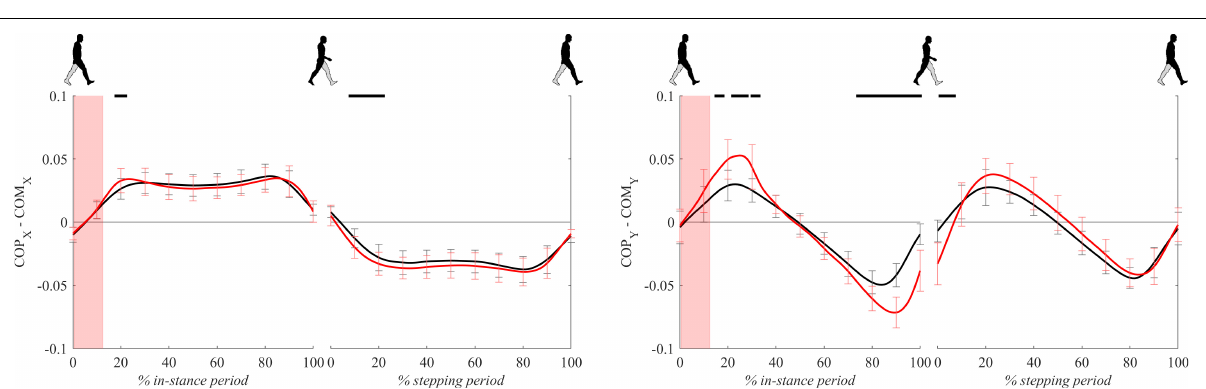
FIGURE 7 | Dimensionless group-average COP-COM responses after outward perturbations ( N = 11 for x direction and N = 12 for y direction). Standard deviations are shown at each 10% of a gait cycle. Black corresponds with the unperturbed experimental condition, red with perturbed experimental conditions. One gait cycle divided into the in-stance and stepping periods, normalized to its duration separately for each experimental condition, is shown following a perturbing push. To visualize normalization of both periods short discontinuity is introduced on abscise. The perturbation period is marked with the red bar. Periods where statistically significant changes were determined between both experimental conditions are indicated with piece-wise continuous black lines on top of each